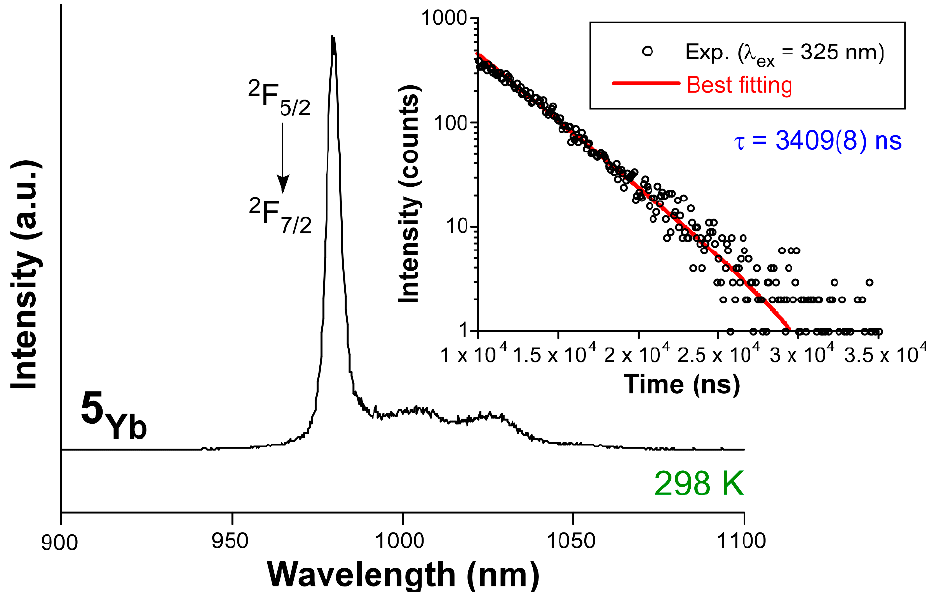
Figure 5. Emission spectra of compound 5 Yb recorded under ligand-mediated excitation in the UV region ( λ ex = 325 nm).